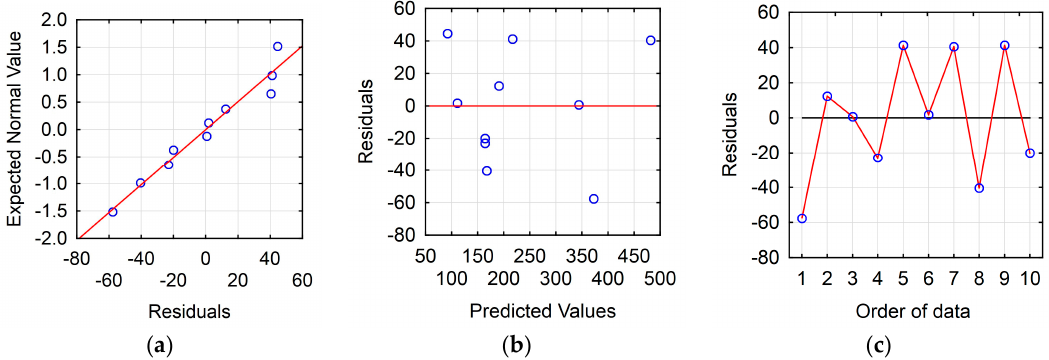
Figure 5. Plots for the check model of the density of the top Sds: ( a ) normal plot of residuals; ( b ) the residuals versus the predicted values; and ( c ) the residuals versus the order of the data.